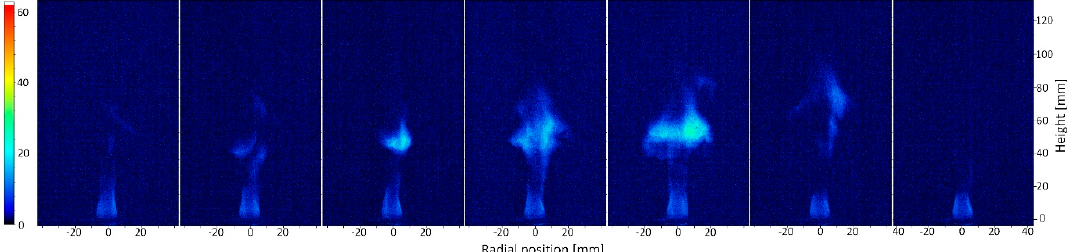
Figure 6. Flame instability near blowout due to a central air jet injection.